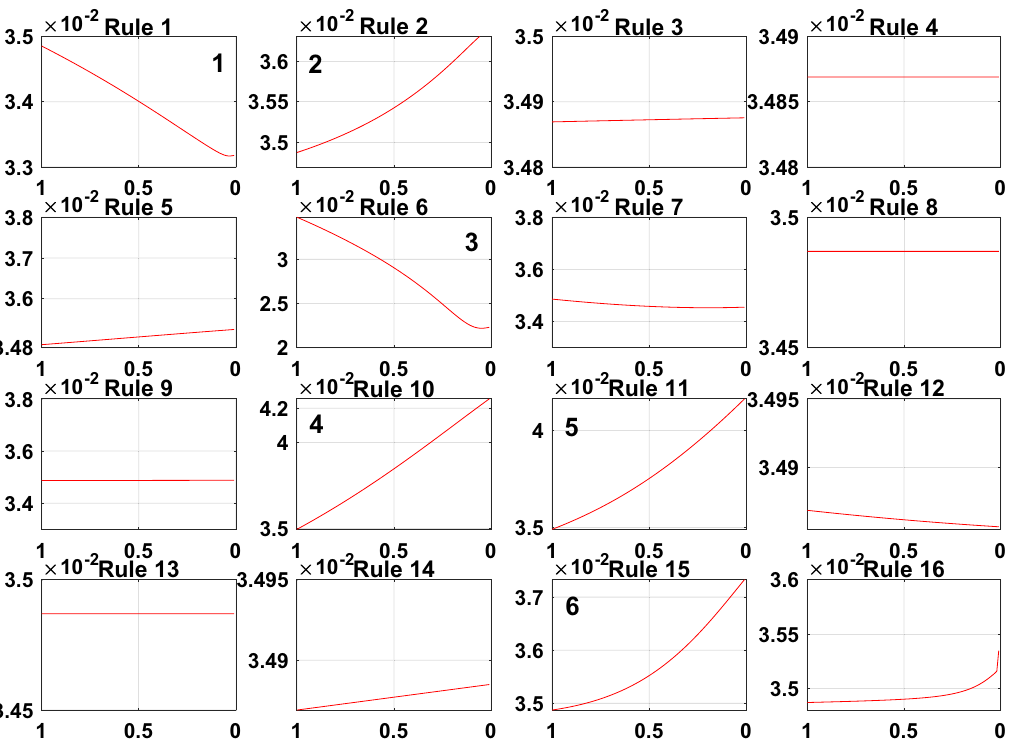
Figure 9. The sensitivity analysis for Sub-BRB1 (x-axis represents rule weights, y-axis represents MSE).